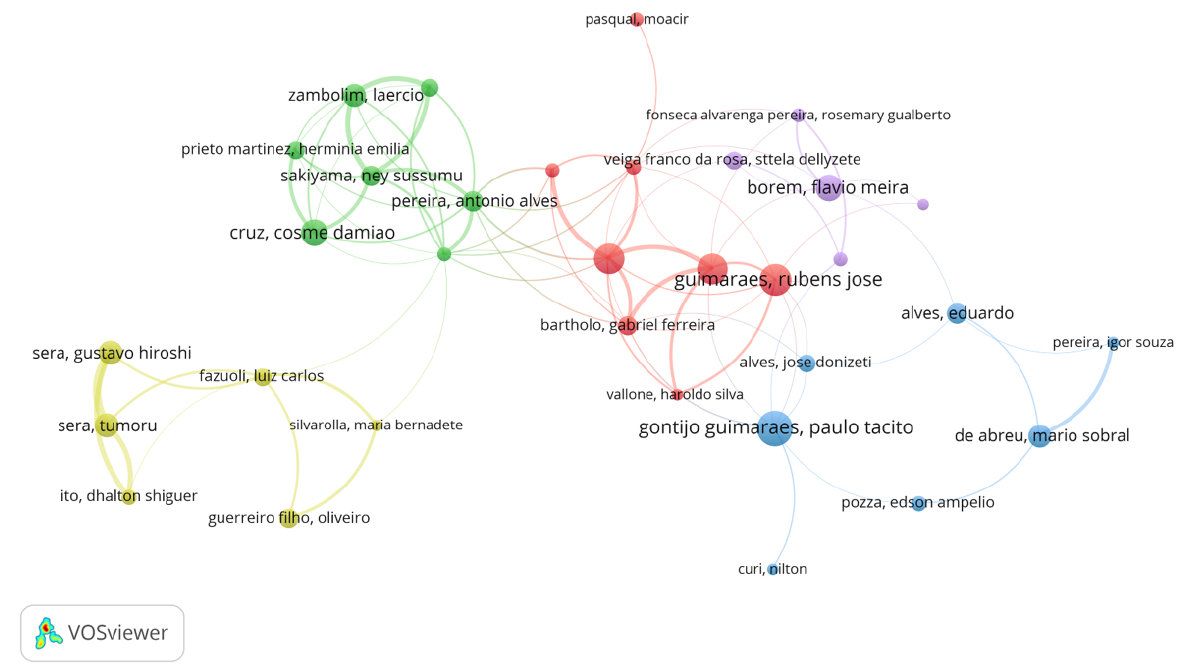
Figure 6. Coffee agronomy research coauthorship network, authors level.